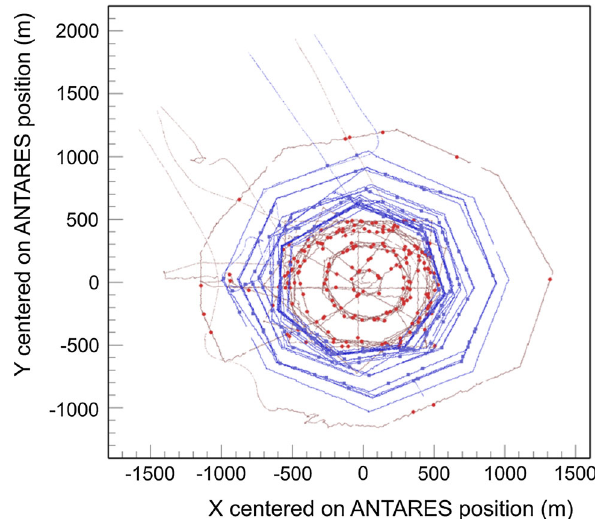
Fig. 8 Ship route in the 2011 (red) and 2012 (blue) campaigns around the center of the ANTARES detector